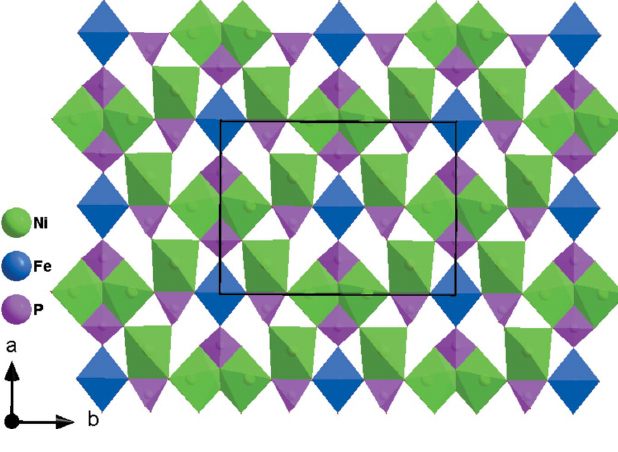
Figure 4 View along the c axis of corner- and edge-sharing [PO 4 ] tetrahedra and [NiO 6 ] octahedra forming a layer parallel to the ab plane.